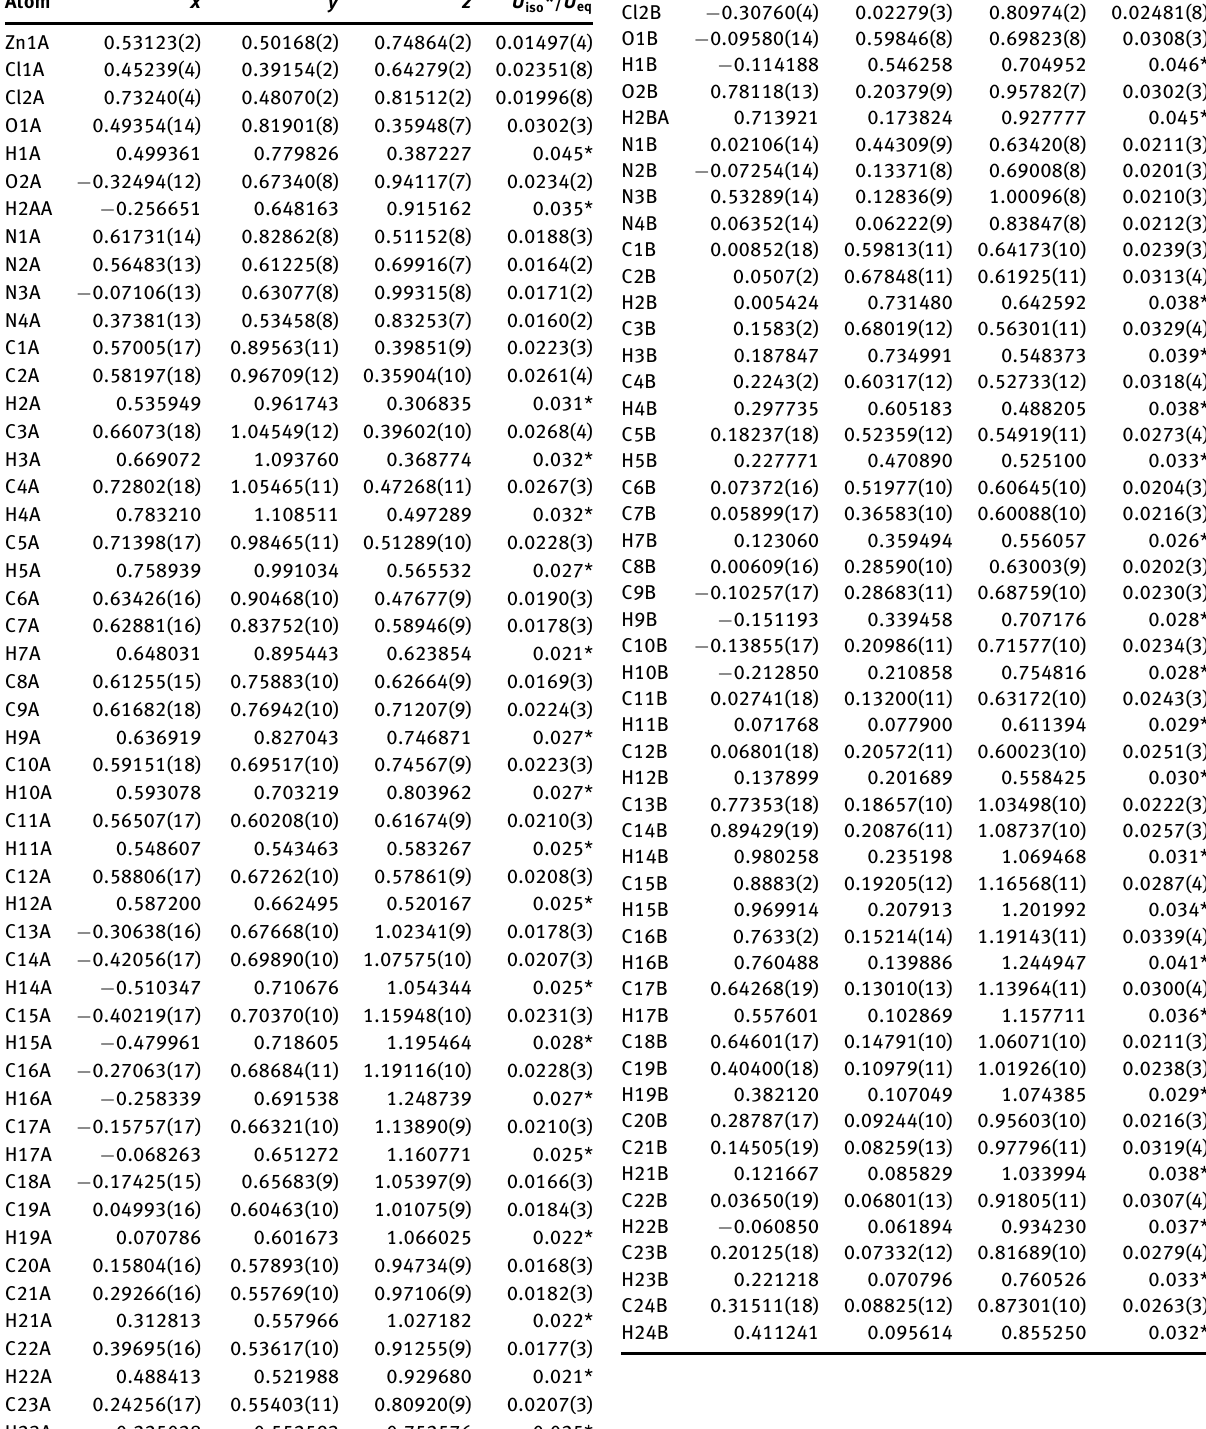
Table 2: Fractional atomic coordinates and isotropic or equivalent isotropic displacement parameters (Å 2